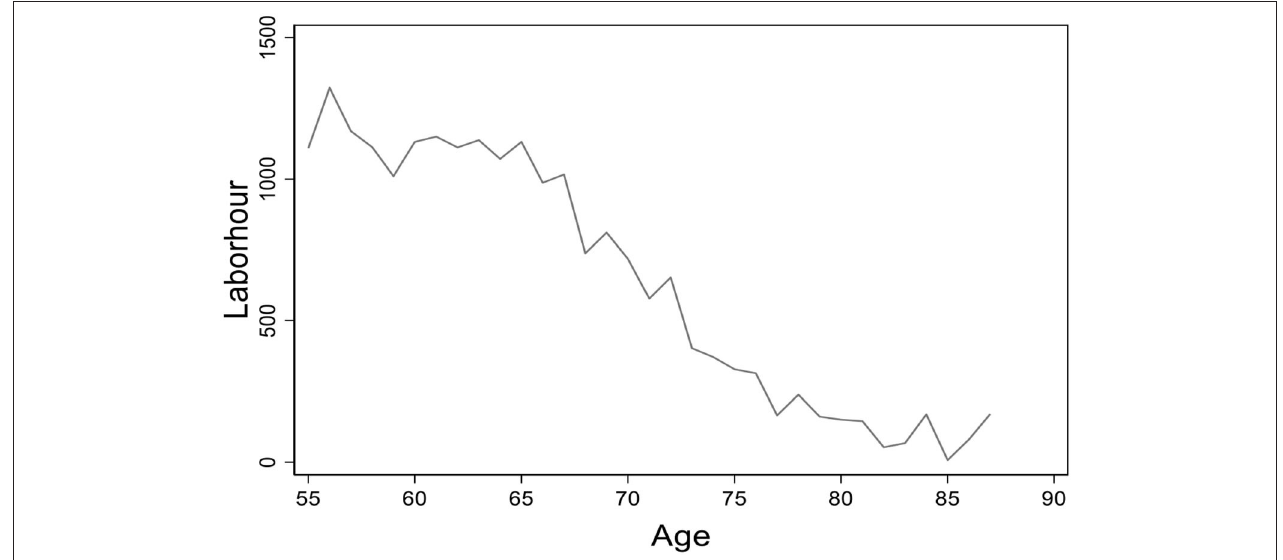
FIGURE 1 | The age distribution of average working hours. Data from the China Health and Nutrition Survey (CHNS) database. The figure presents the age distribution of average working hours for the elderly in rural